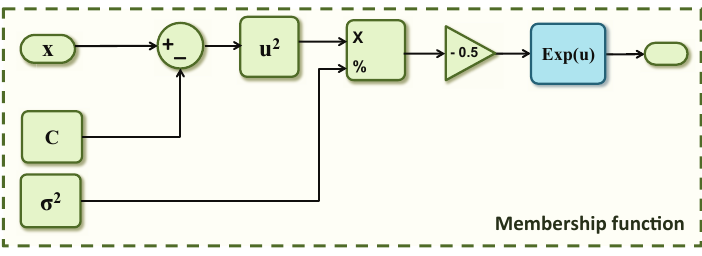
Figure 20. Gaussian membership function.